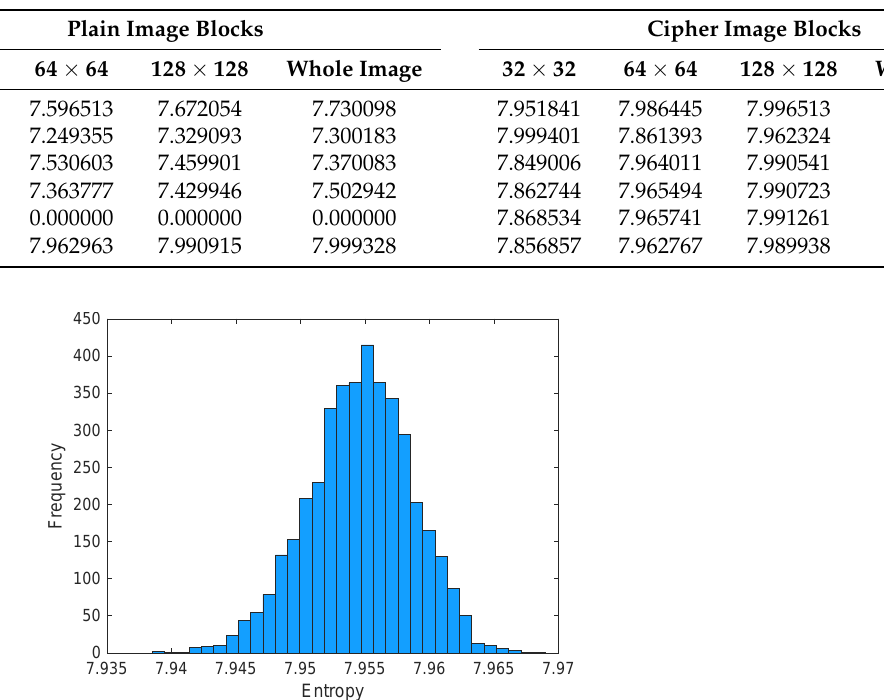
Table 4. Average block entropy of various plain images and their corresponding cipher images.